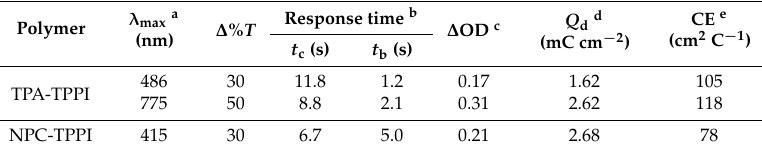
Table 2. Electrochromic properties of the polymer films.